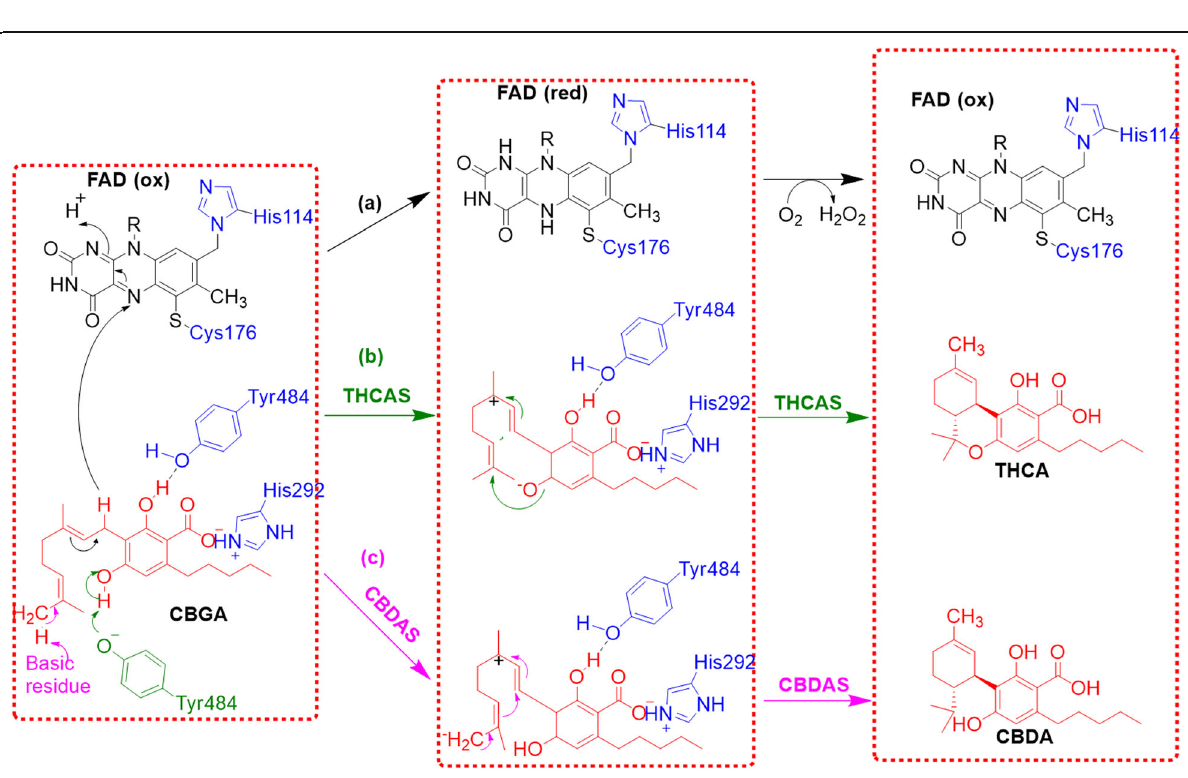
Fig. 5 Reaction mechanism for the conversion of cannabigerolic acid (CBGA) into tetrahydrocannabinolic acid (THCA) proposed by Taura and cowerkers (2019). a Covalently incorporated flavin adenine dinucleotide (FAD) in black, b THCA synthase pathway is shown in green, and c cannabidiolic acid (CBDA) synthase pathway is shown in purple; CBDA and THCA in red. The red box represents the active site of the